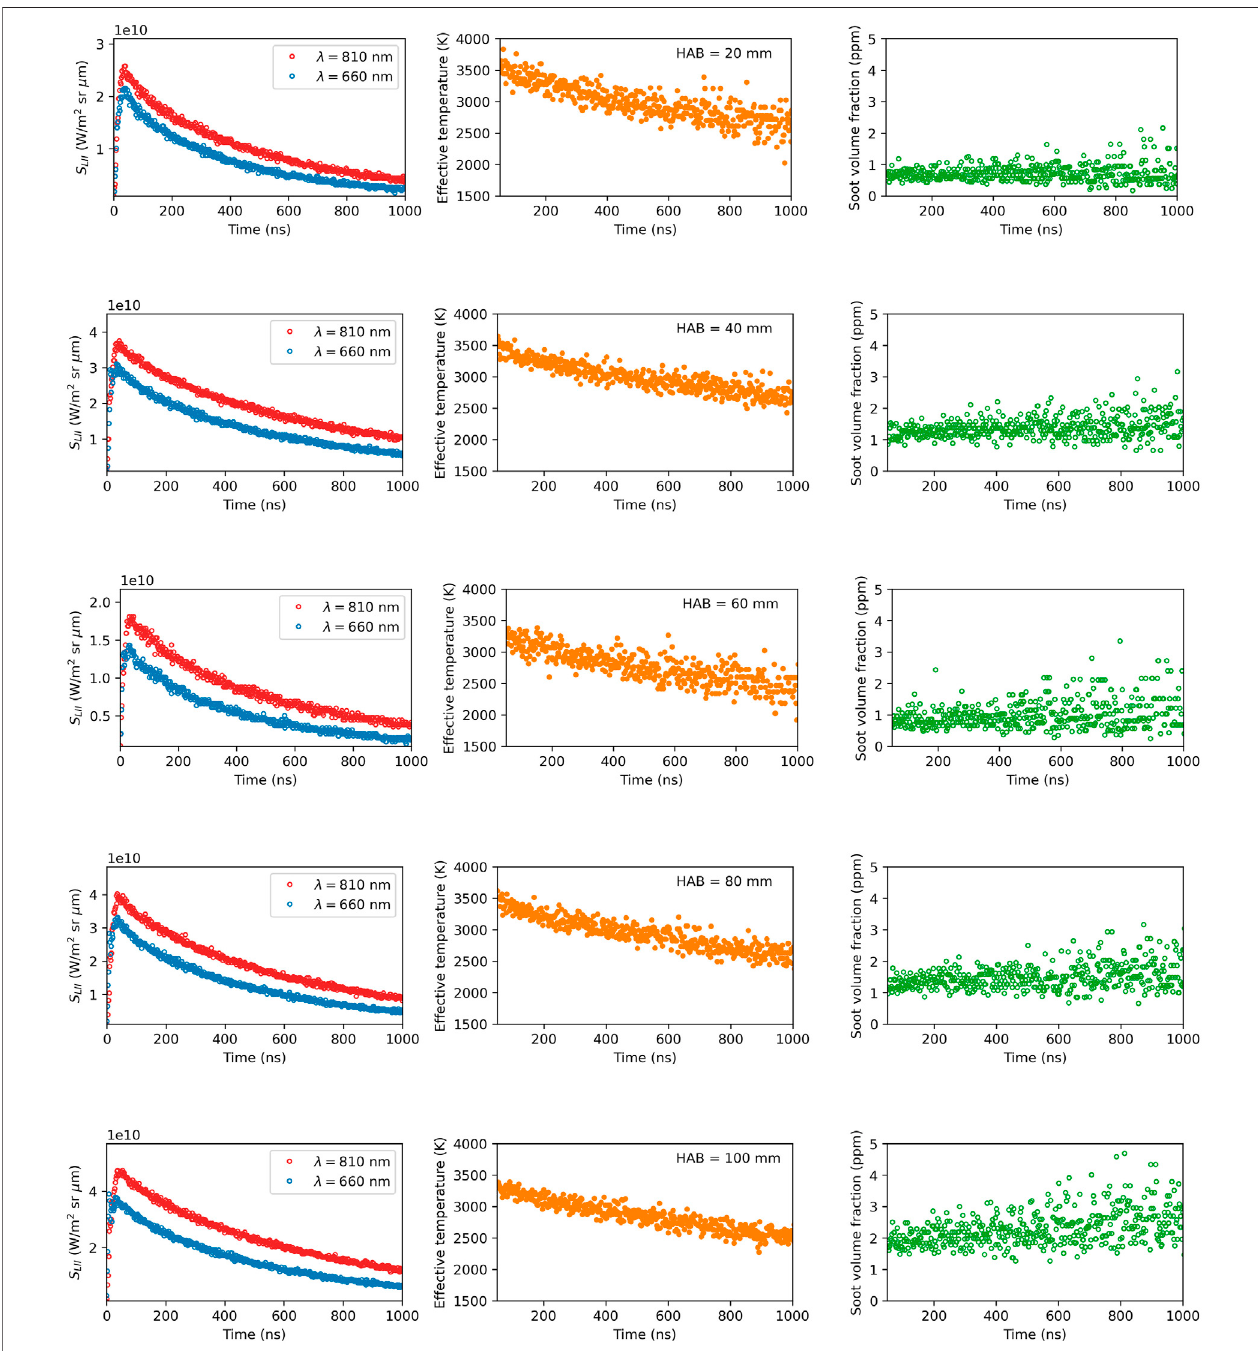
FIGURE 5 | Each row represents the instantaneous time-resolved LII signal decay in logarithmic scale (left) , the effective soot temperature (center) , and soot volumefractioncomputedatbothwavelengths (right) ,forHABsfrom20to100 mm.Notethattheeffectivesoottemperatureandthesootvolumefractionaredisplayed at 35 ns after laser pulse reaches the fl